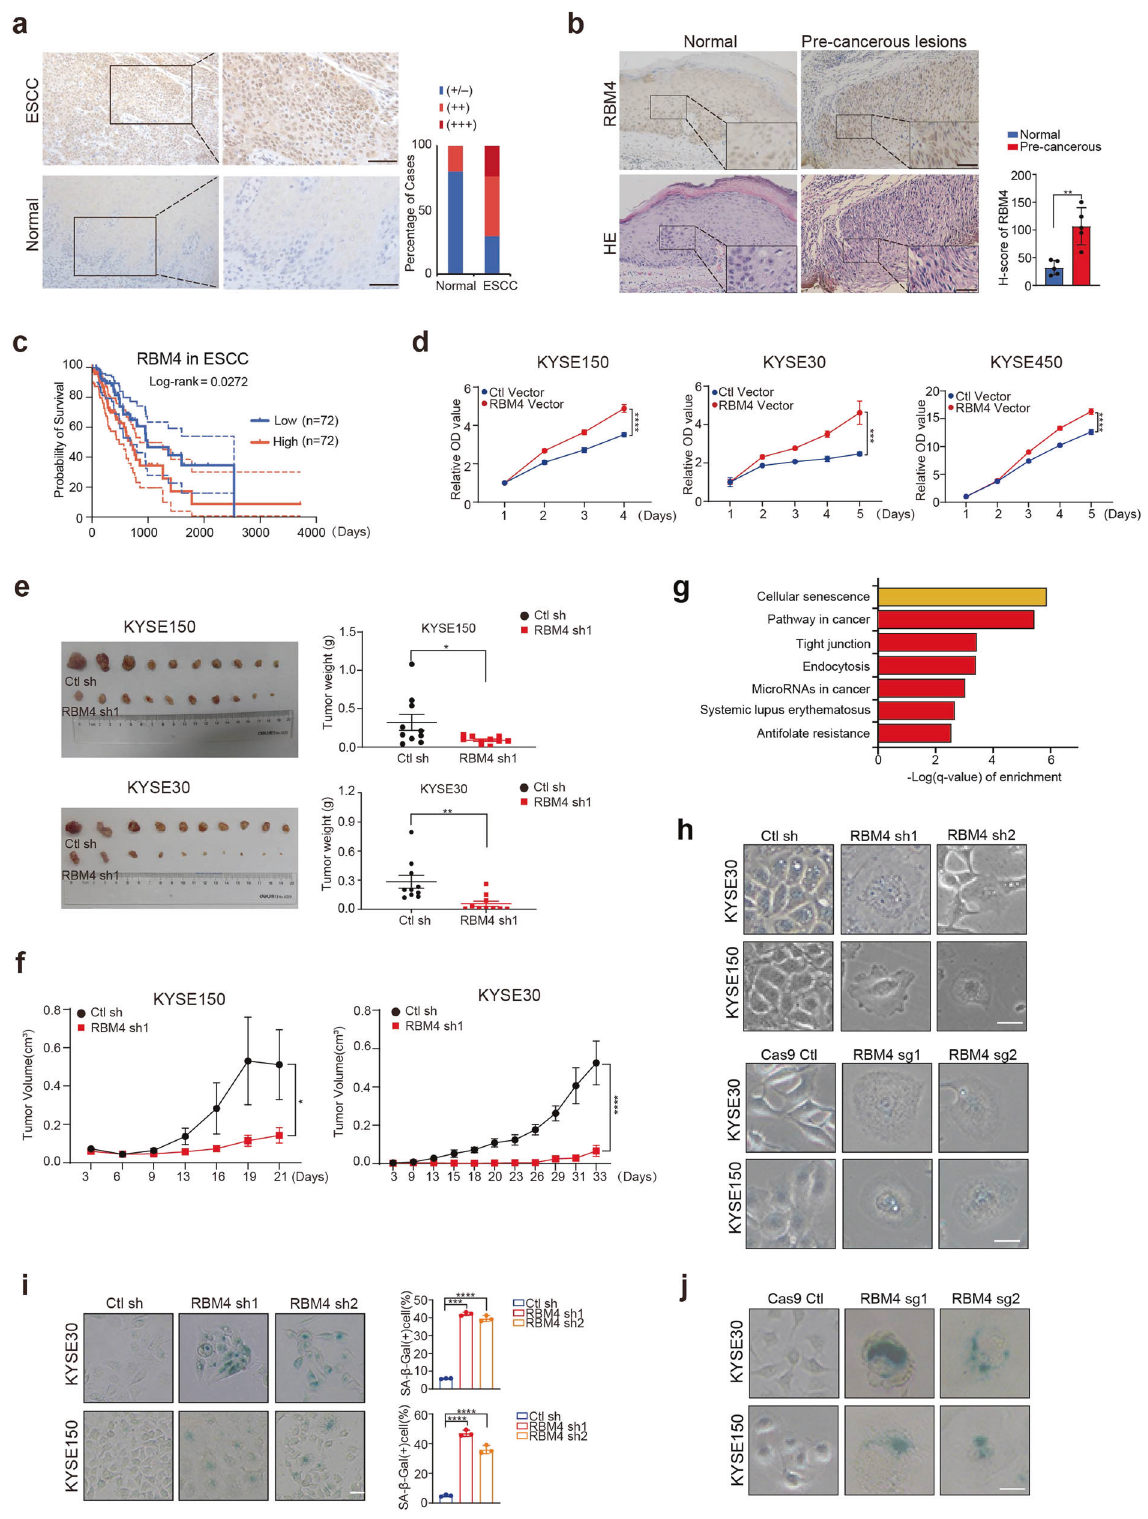
Supplementary Fig. 1, we next de fi ne whether RBM4 might play a role in promoting senescence bypass during ESCC